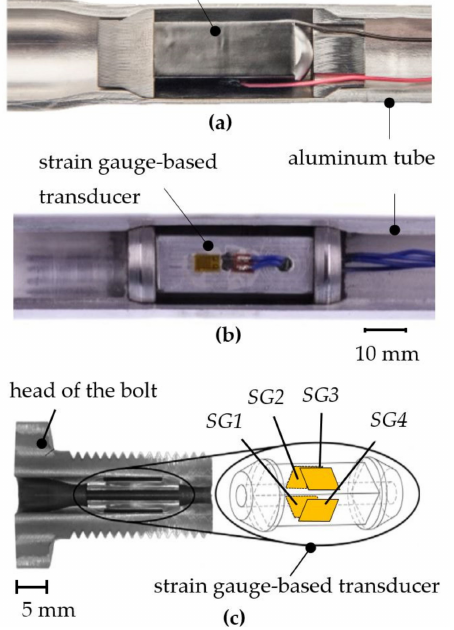
Figure 1. Load-bearing structures with integrated strain gauge-based and piezo electric transducers produced by rotary swaging. ( a , b ) Sensory hollow shafts [45]. ( c ) Sensory bolt